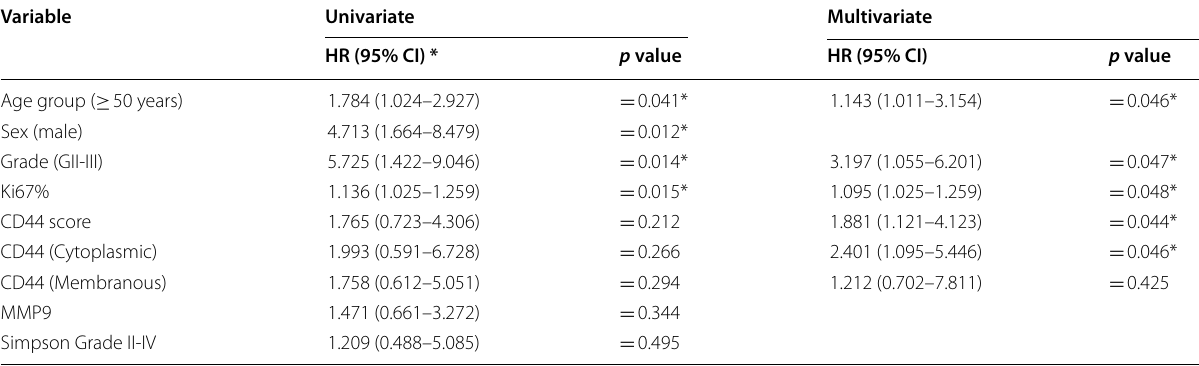
HR hazard ratio, CI confidence